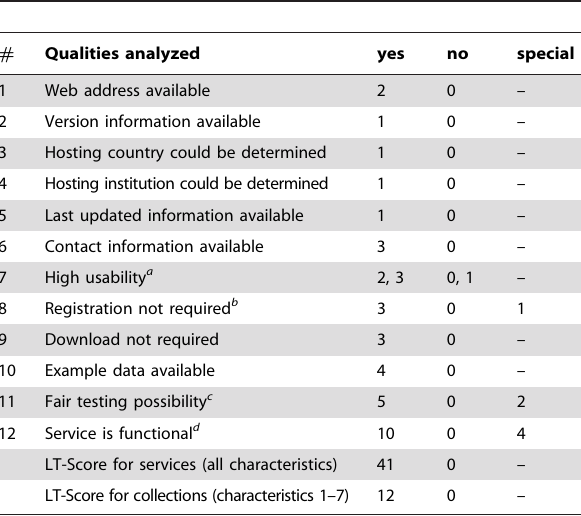
Table 2. Scoring function and qualities analyzed for the LT-